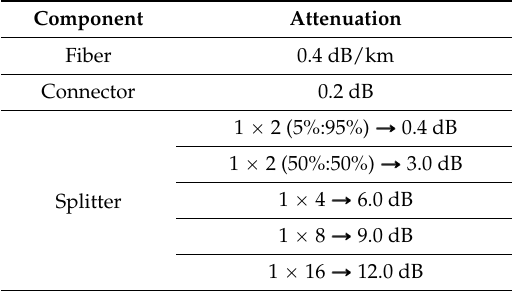
Table 3. Component insertion